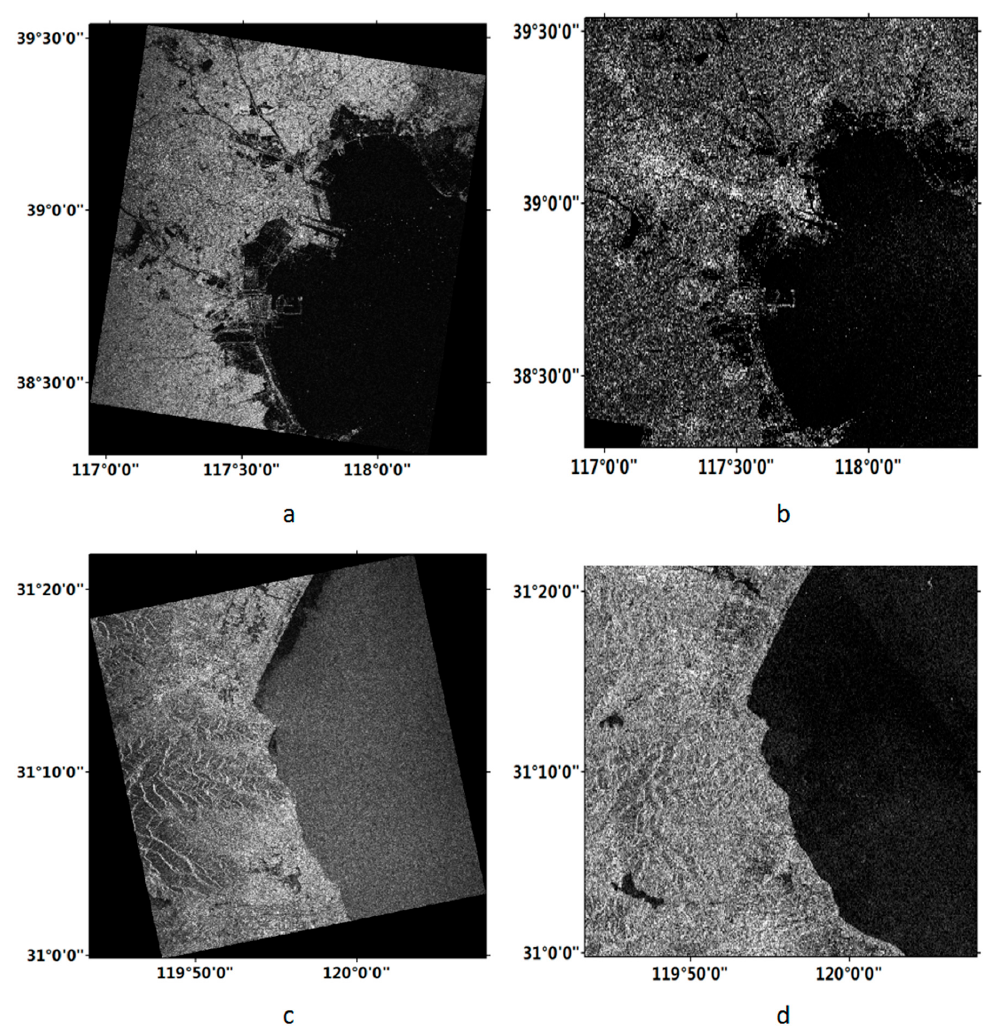
Figure 2. Used images of the testing sites. ( a ) Gaofen-3 image of Bohai; ( b ) Sentinel-1 image of Bohai; ( c ) Gaofen-3 image of Taihu; ( d ) Sentinel-1 image of Taihu.